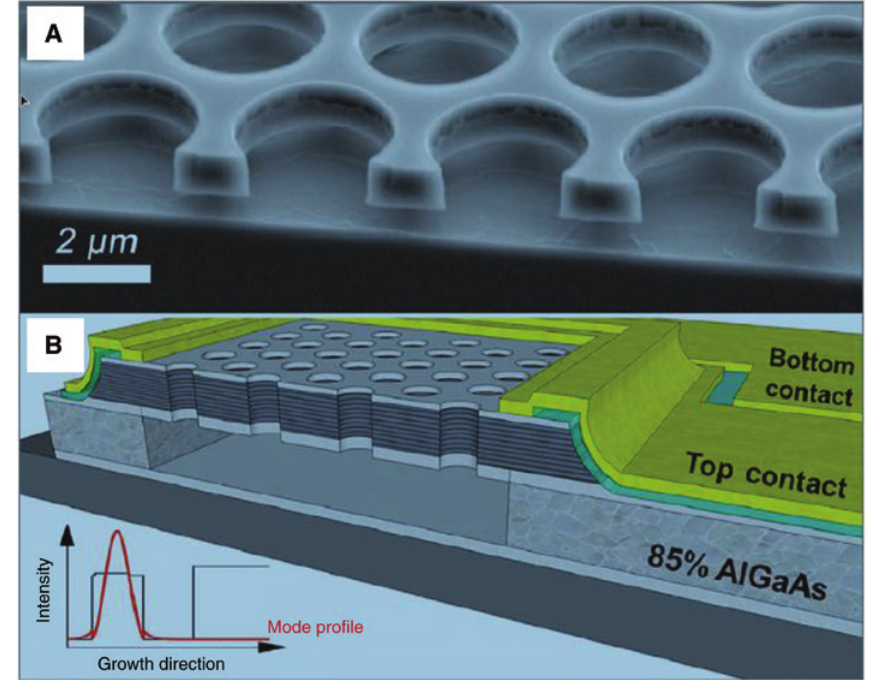
Figure 12: PCS-QWIP design. (A) SEM image of a cleaved PCS and (B) cross-section through the PCS-QWIP structure